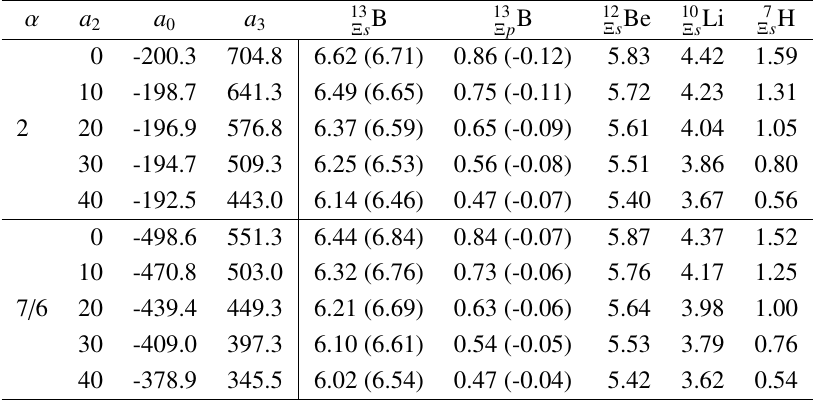
Table 1. The removal energies B Ξ (in MeV) for the Ξ − 1 s and 1 p states of 13 obtained with Ξ N Skyrme forces of di ff erent parameters α , a 0 [MeVfm 3 ], a 2 [MeVfm 5 ], a 3 [MeVfm 3 α ] and a 1 = a 4 = 0. With these parameters, the Ξ − 1 s and 1 p removal energies of 15 B values in brackets are for spherical 1.13 MeV, respectively. 13 Ξ